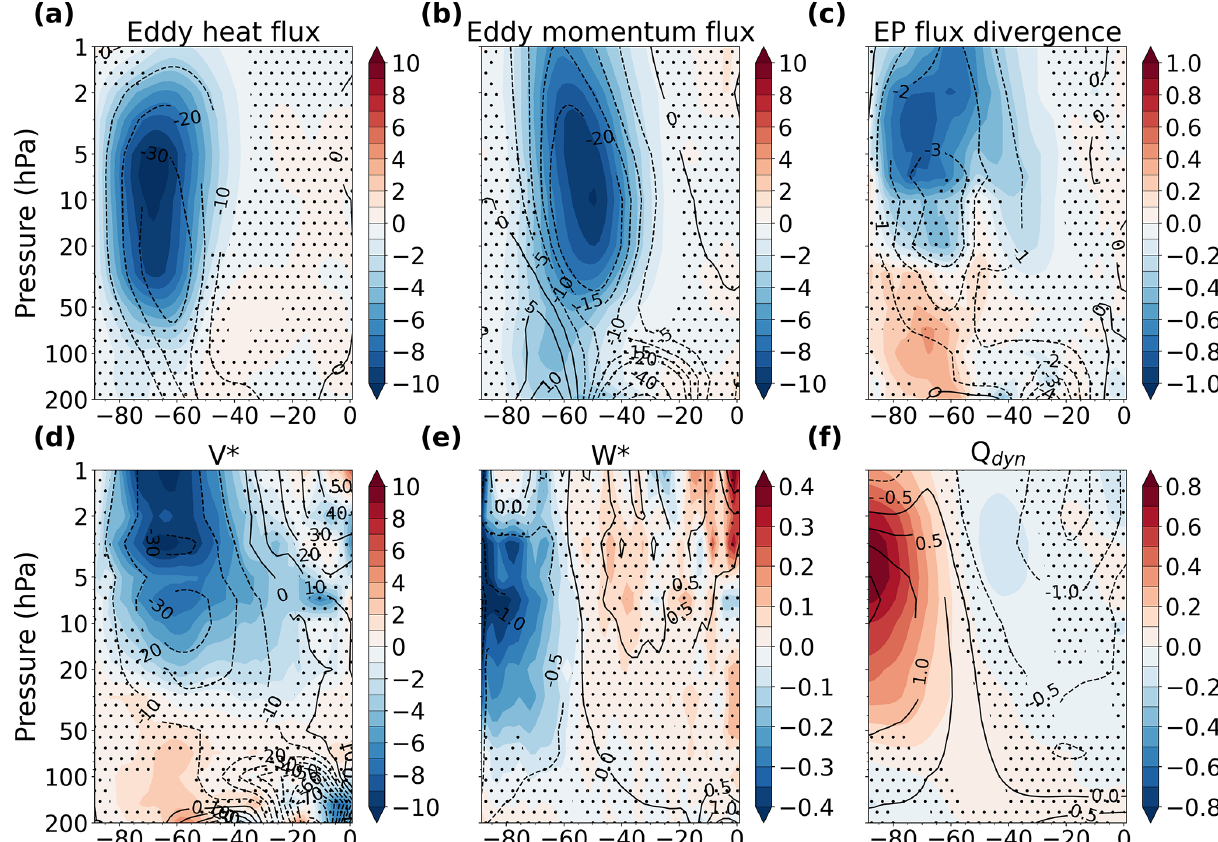
Figure 4. November latitude–height difference between REF and NoODS in the eddy heat flux ( a ; Kms − 1 ), the eddy momentum flux ( b ; m 2 s − 2 ), the divergence of the EP flux ( c ; ms − 1 d − 1 ), the meridional residual velocity ( d ; cms − 1 ), the vertical residual velocity ( e ; mms − 1 ), and the dynamical heating rate ( f ; Kd − 1 ) for the period 1978–2002 (color shading). Contours in each panel show the corresponding clima- tology from REF. Stippling masks values that are not significant at the 95% confidence